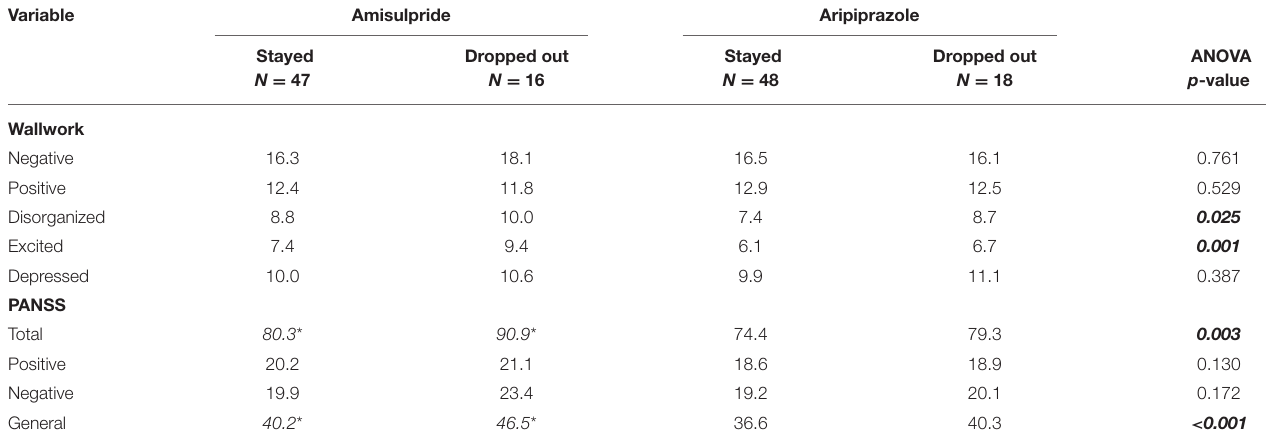
TABLE 4 | Baseline psychopathology score on patients with and without follow up data and p-values for ANOVA comparing the four groups.